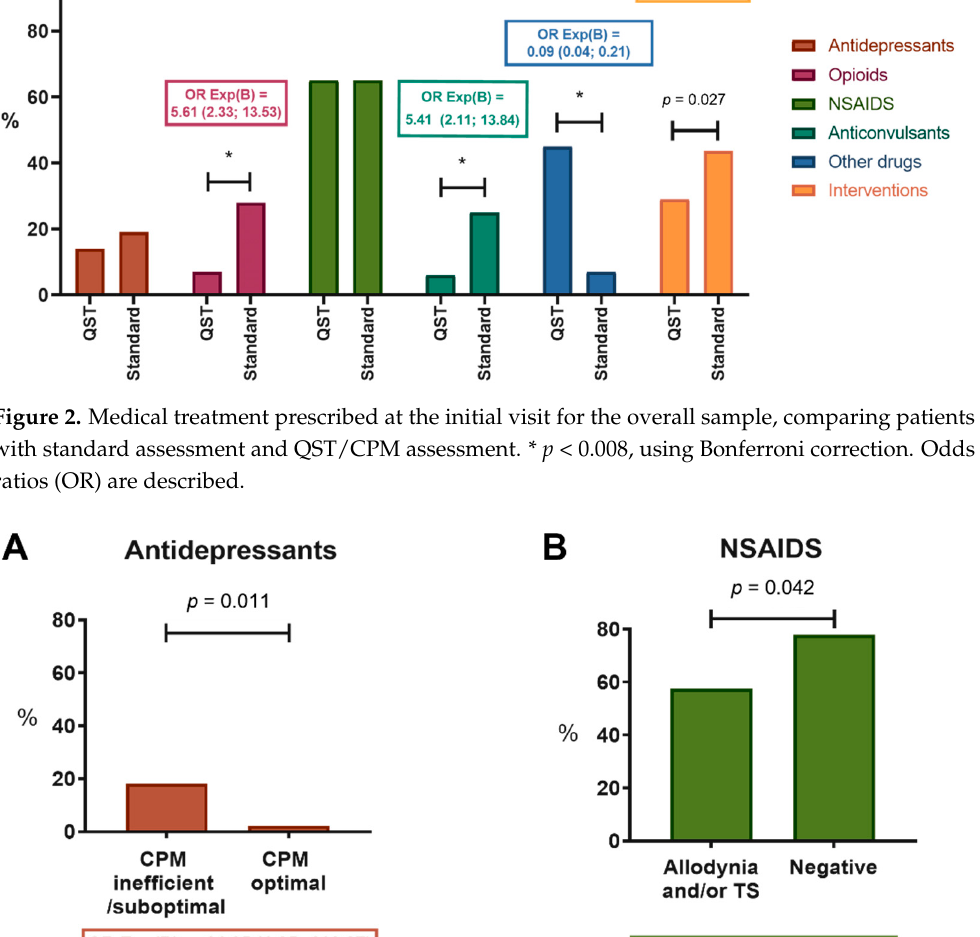
Figure 3. Comparison of medical treatment prescribed at the initial visit specific to QST/CPM rec- ommendations. ( A ) The proportion of patients with a prescription for antidepressants was greater among those with an inefficient or suboptimal endogenous inhibitory pain response; ( B ) The pro- portion of patients with a prescription of NSAIDs was smaller among those who showed positive signs of allodynia and/or temporal summation (TS). Odds ratios (OR) are described.